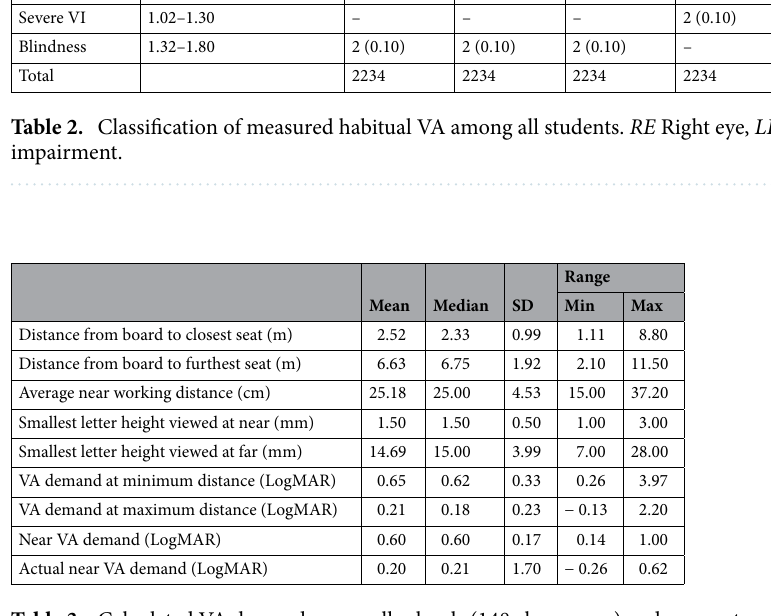
Table 3. Calculated VA demand across all schools (148 classrooms) and parameters used in calculation. SD Standard deviation.